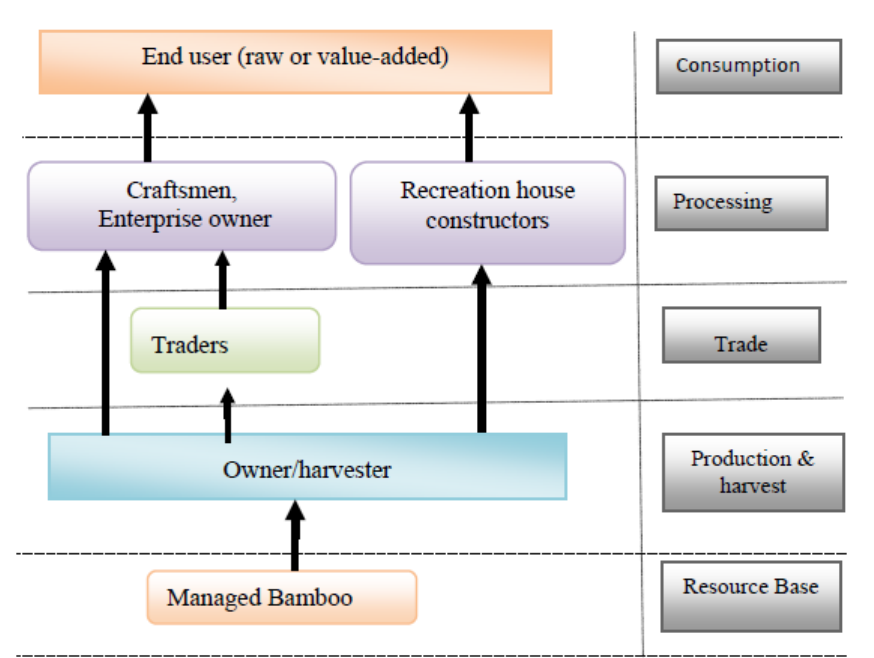
Figure 4. Typical value chain structure from Awi and